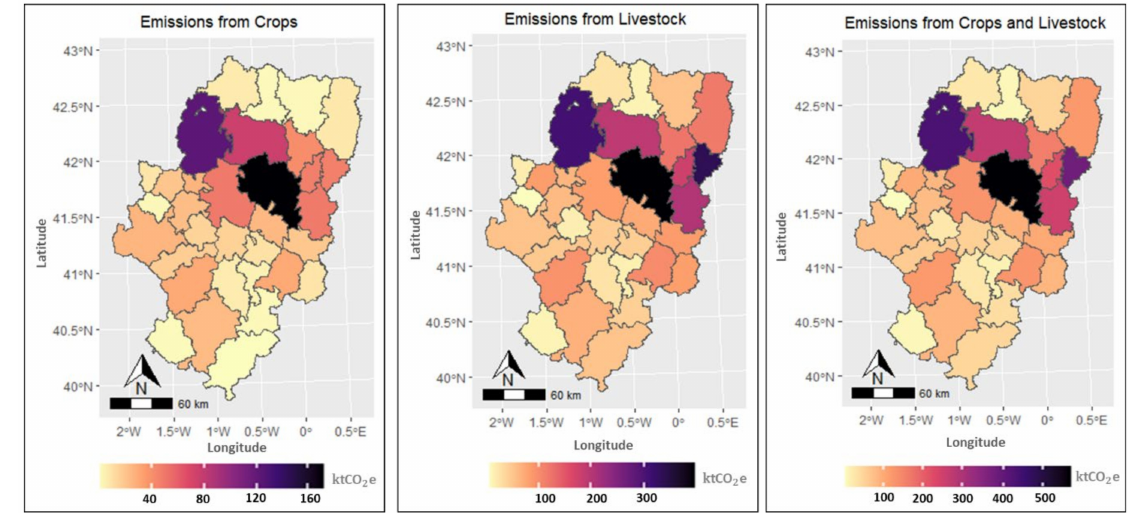
Figure 2. GHG emissions by county from crops, livestock, and the sum of crops and livestock.